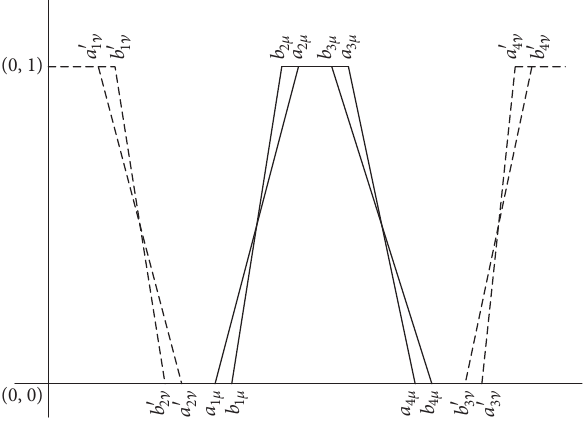
Figure 9: Pictorial representation of Example 88.